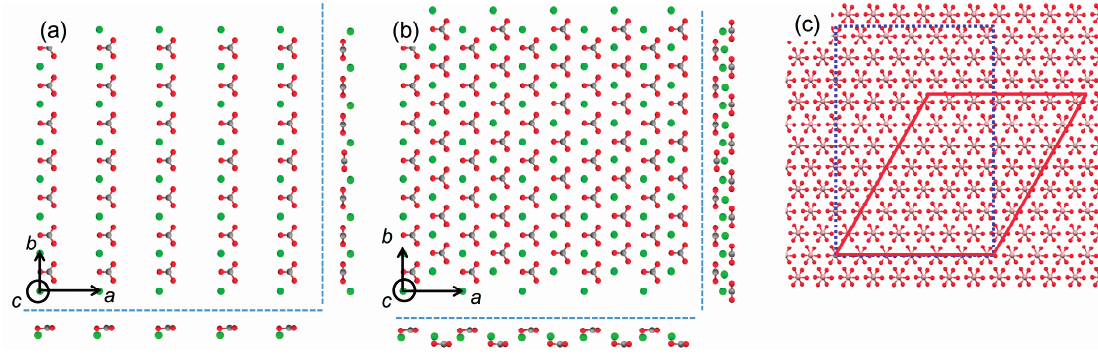
Figure 6. Molecular models of the (0 0 1) plane of aragonite along with the side views (outside dashed lines): ( a ) orthorhombic and ( b ) pseudo-hexagonal arrangements; ( c ) Maximum supercell dimensions of aragonite (0 0 1) that generated the dimensionless potential ( V / V o ) less than 0.5 with the (0 0 1) plane of Al 2 O 3 : orthorhombic (dotted line) vs. pseudo-hexagonal (solid line)